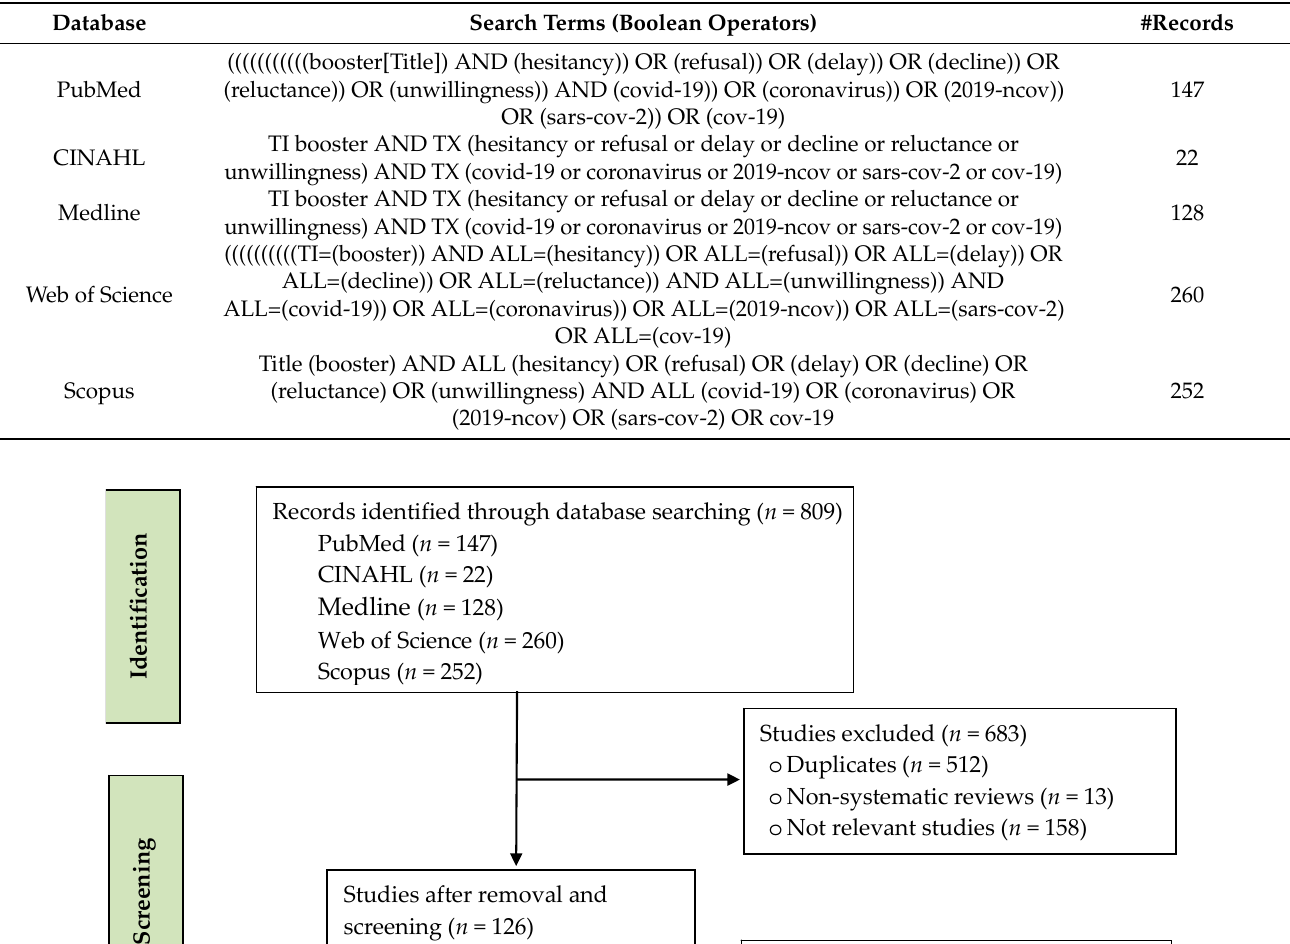
Table 1. Search strategy.